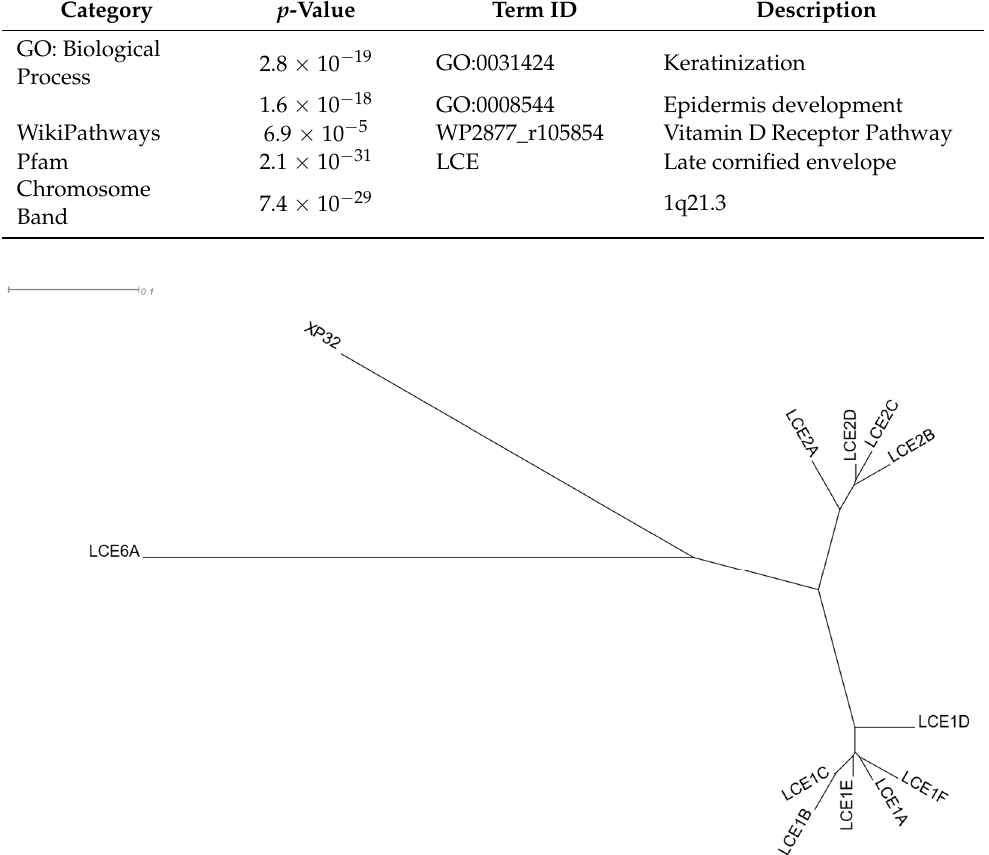
Figure 9. Phylogenetic tree resulting from MUSCLE multiple sequence alignment of the protein sequences of the genes of the HGCA2.0 C1orf68 (XP32) coexpression clade, as viewed by Dendroscope [91] .